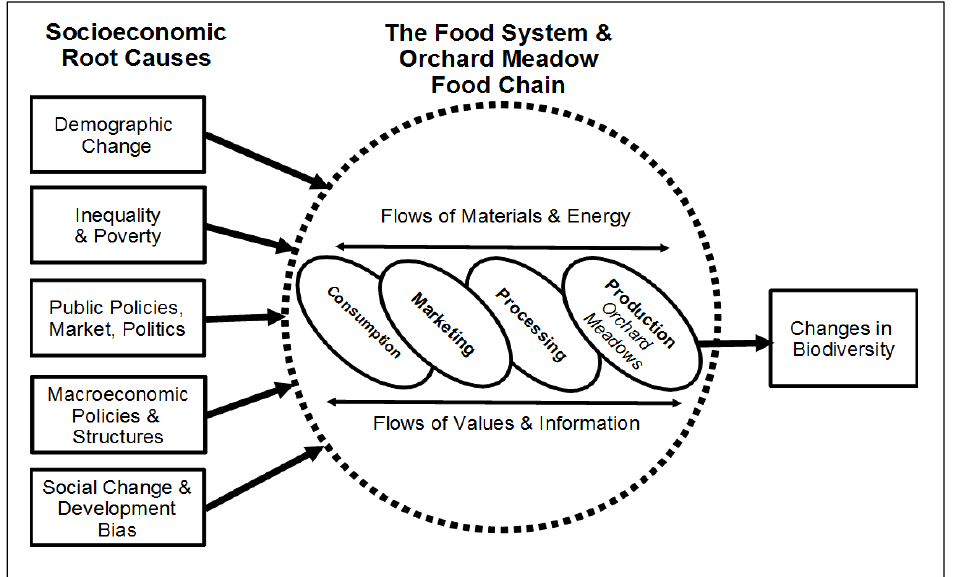
Figure 2. Schematic Diagram of the Analytical Framework Used in This